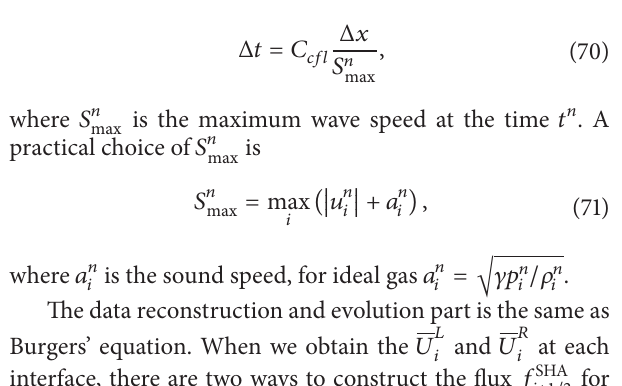
Figure 11: SHA method applied to inviscid Burgers’ equation for discontinuous initial value; numerical (symbols) and exact (line) solutions are compared at 𝑡 = 0.15